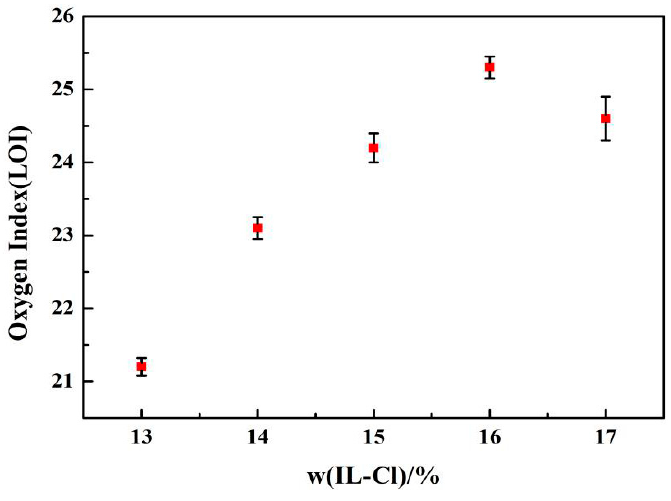
Figure 5. LOI results of IWPU films.